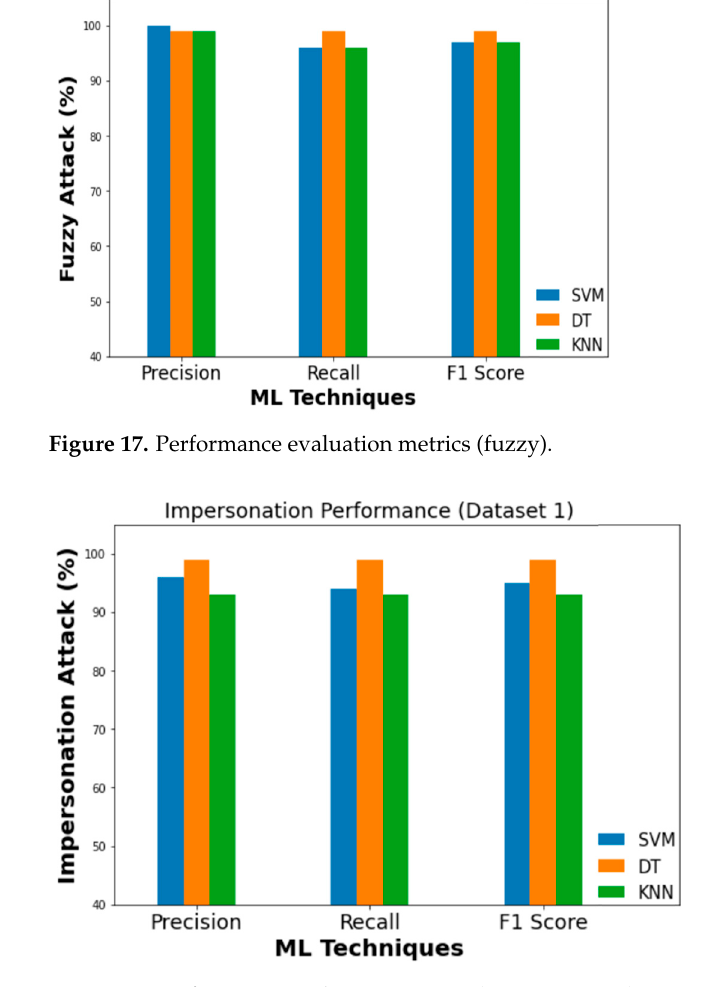
Figure 18. Performance evaluation metrics (impersonation).